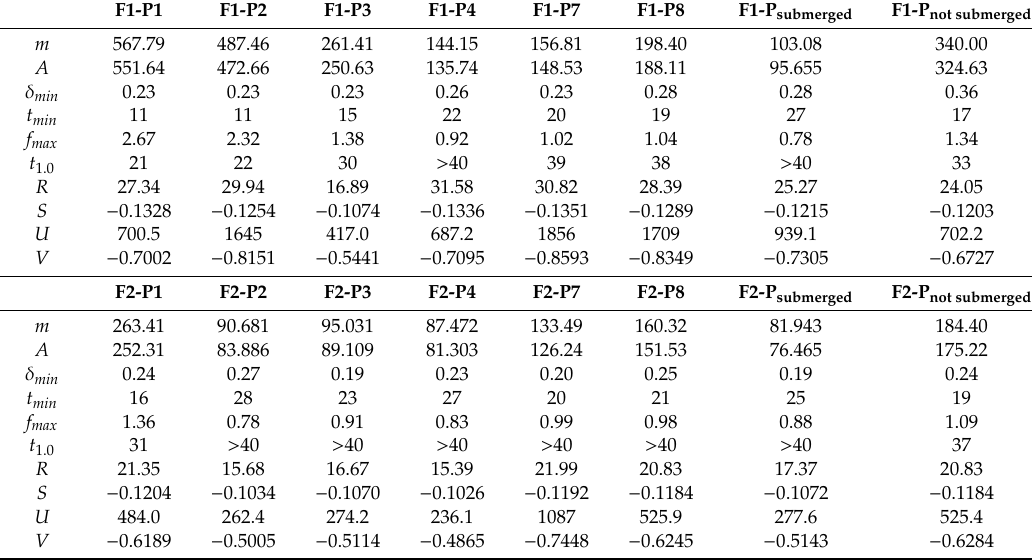
Table 5. Diverse parameters describing to the indicated master curves and their respective derived